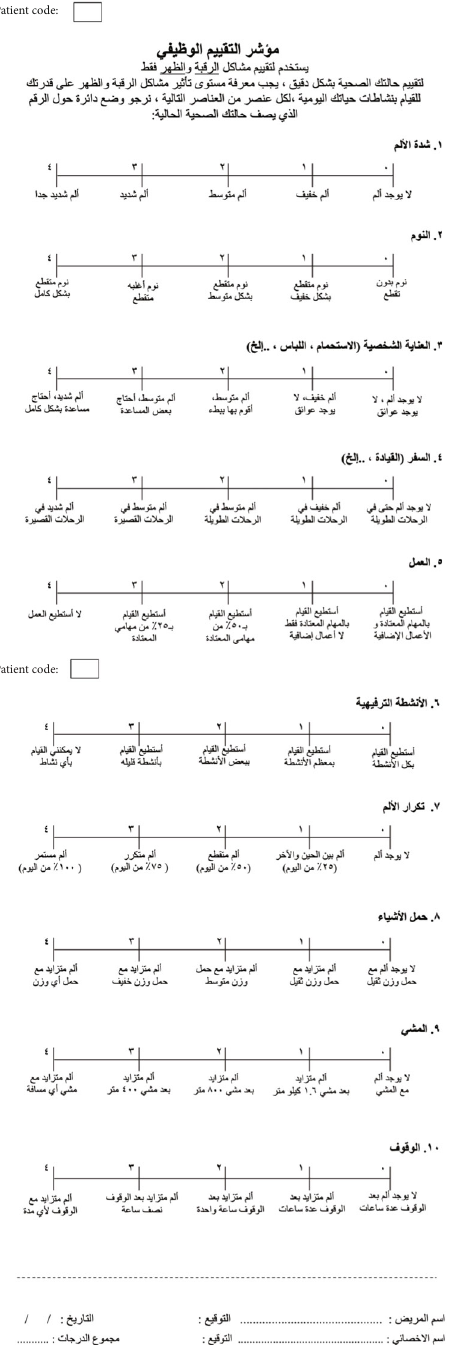
Figure 2: Functional Rating Index-Arabic (FRI-Ar) questionnaire.